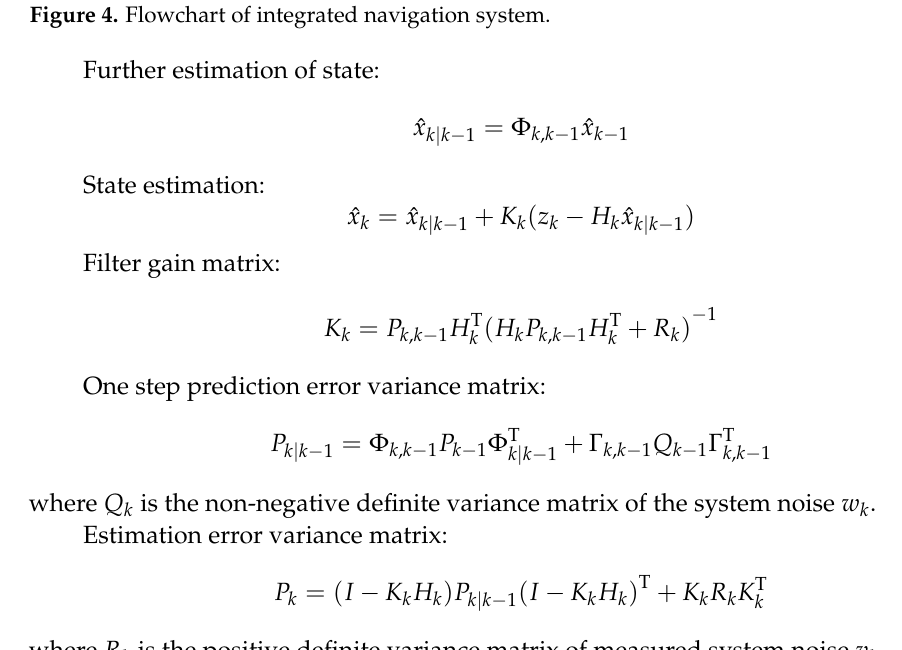
Figure 4. Flowchart of integrated navigation